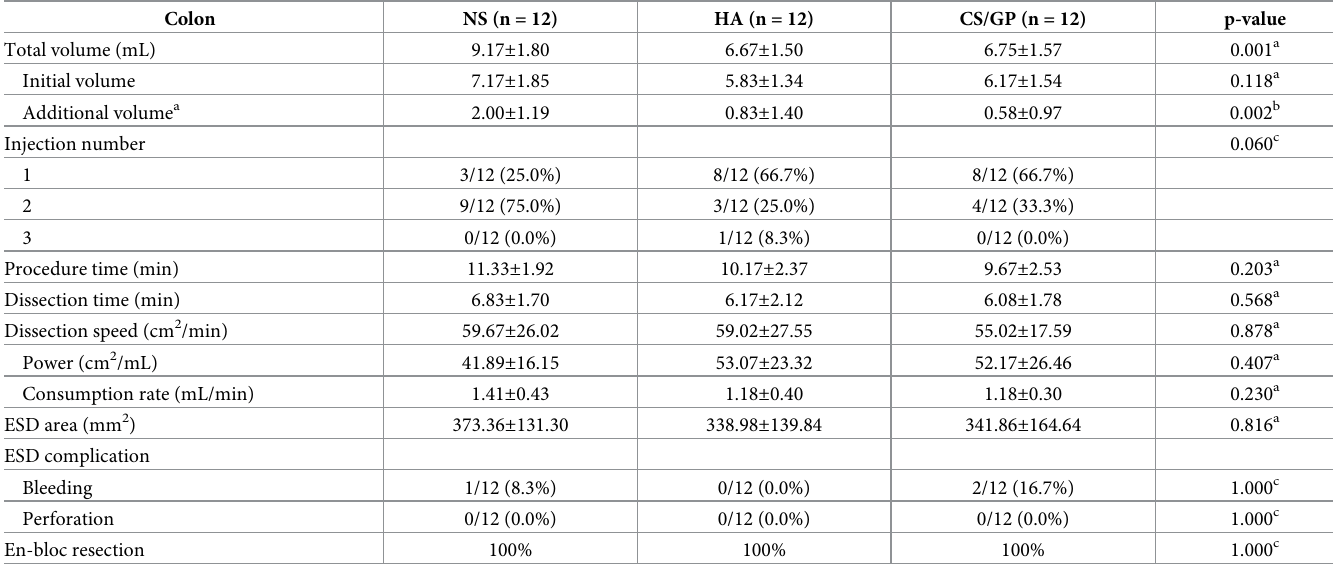
Table 4. Comparative colonic endoscopic submucosal dissection-related parameters between solutions.